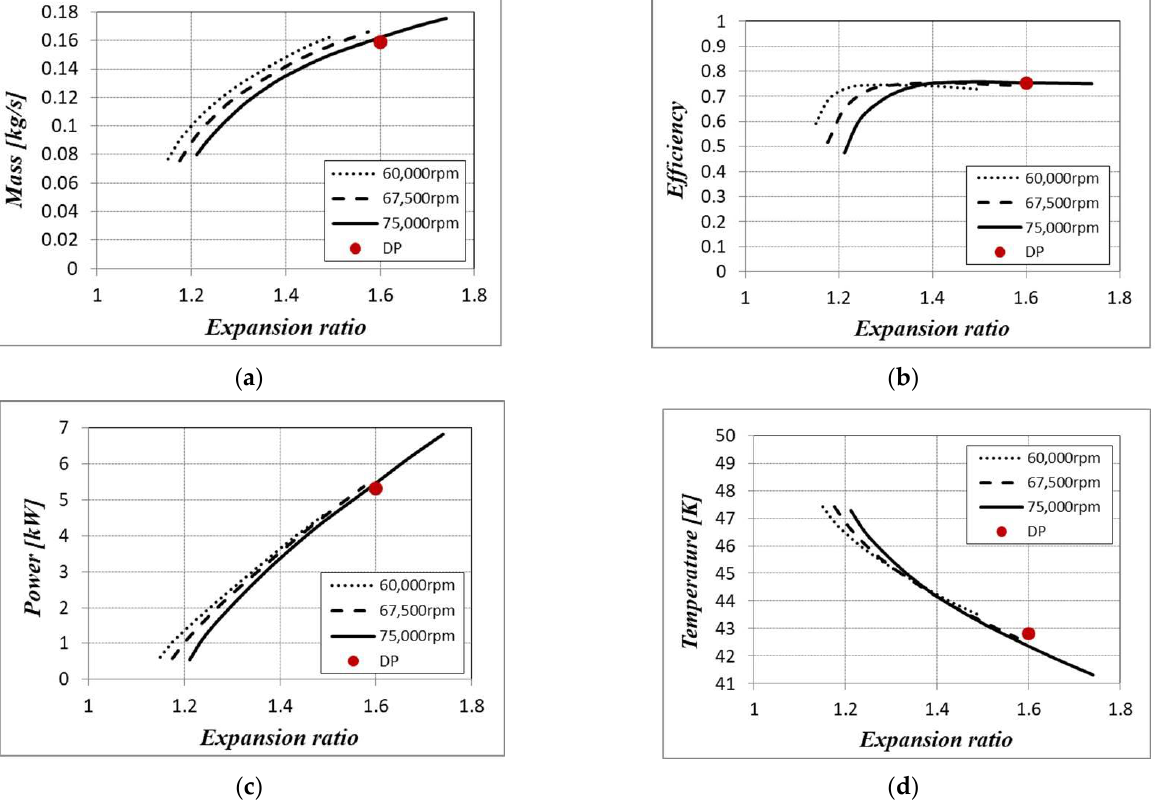
Figure 7. Performance prediction curves from numerical analysis: ( a ) expansion ratio vs. mass; ( b ) expansion ratio vs. efficiency; ( c ) expansion ratio vs. power; ( d ) expansion ratio vs. expander outlet temperature.